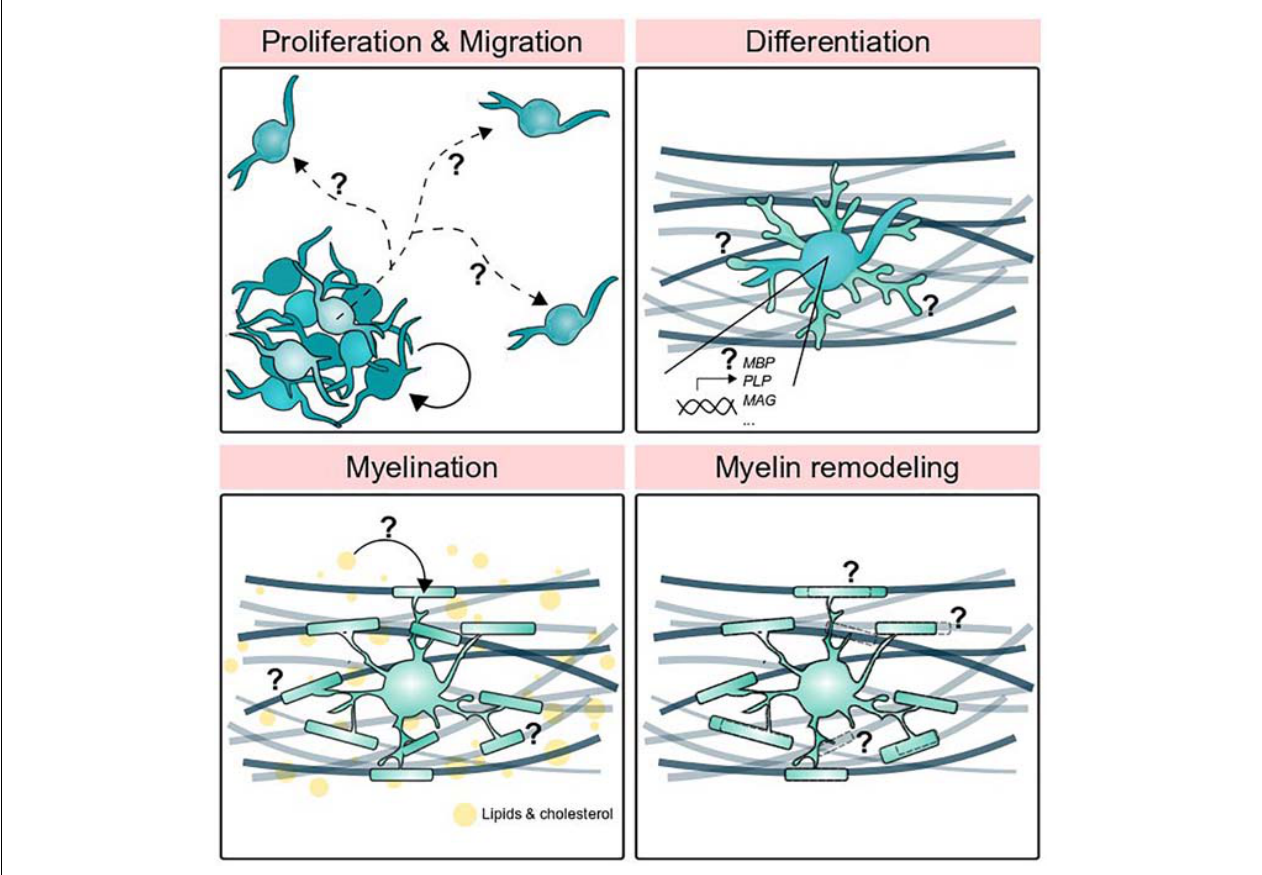
FIGURE 1 | Stages of oligodendrocyte development supported by other glial cells. Oligodendrocyte precursor cells proliferate and migrate, but what determines precise migratory routes and proliferation rate? How do oligodendrocytes differentiate and turn on myelin gene expression? Circulating lipids are a major component of myelin, but where do those lipids come from? Finally, how do myelin sheaths grow, shrink, and disappear